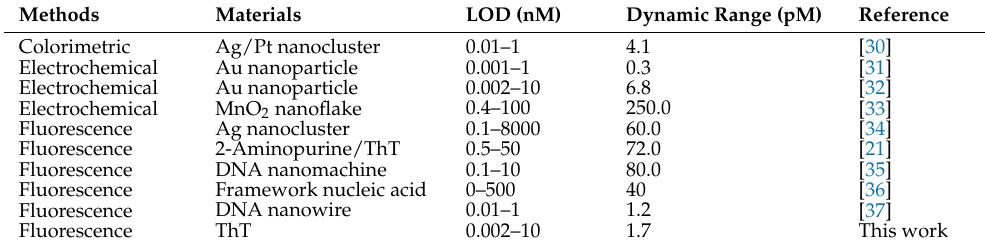
Table 1. Comparison of different methods for the detection of miRNA-21.